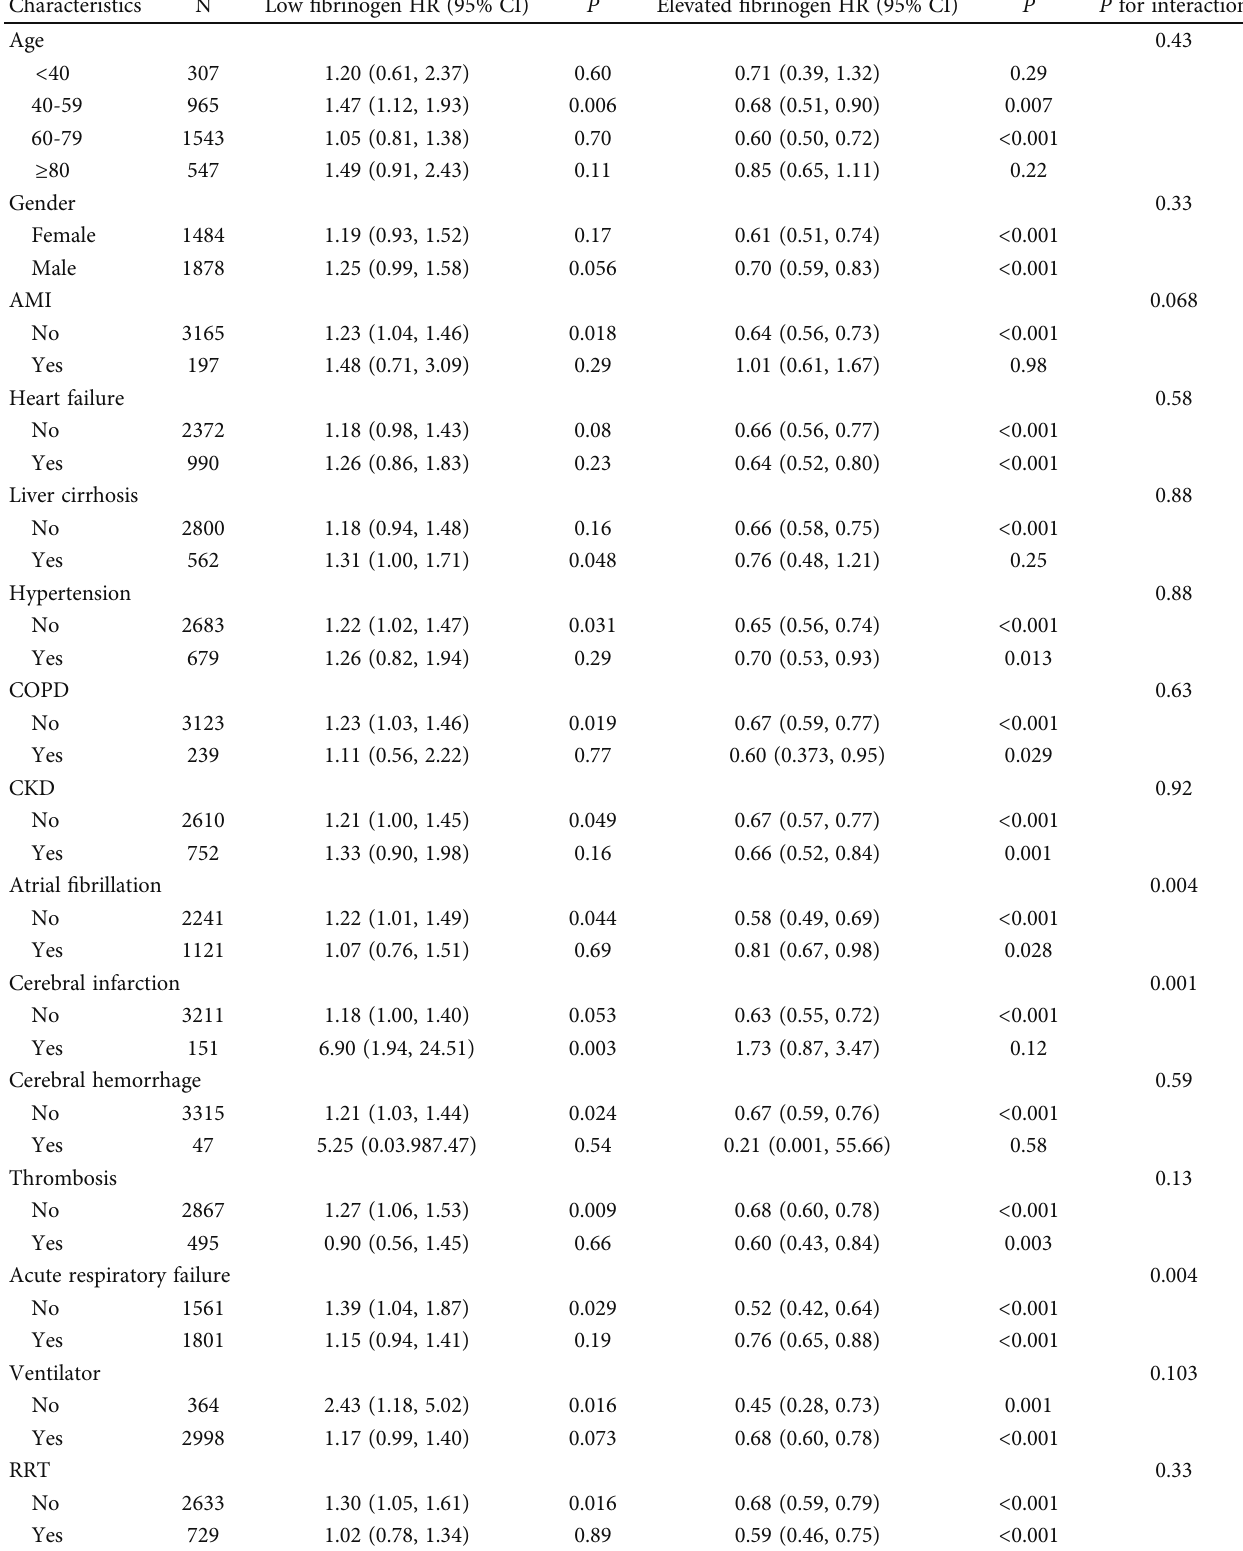
Table 6: Subgroup analysis of the association between fi brinogen and inhospital mortality based on model 3.